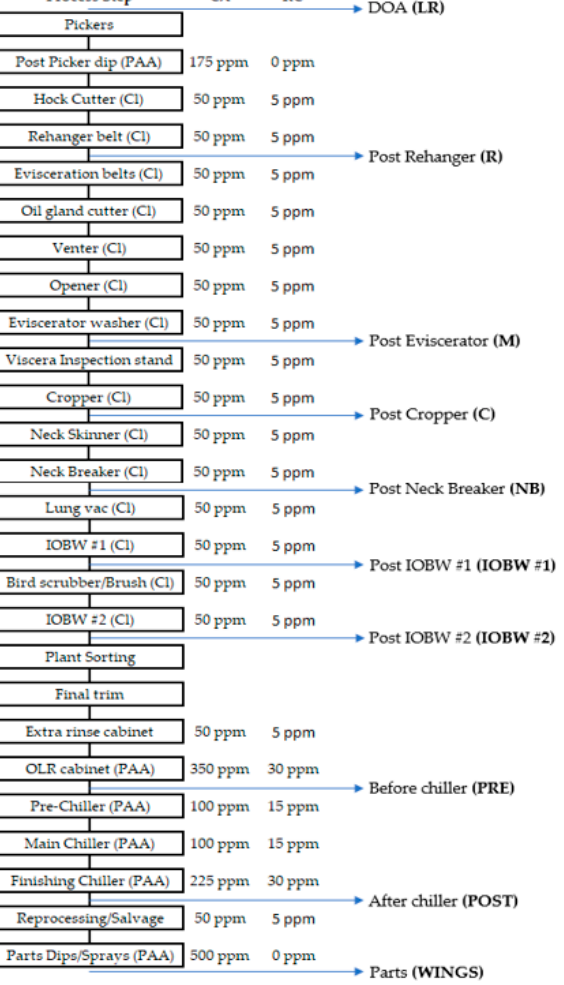
Figure 1. General flow chart of the process, identifying the CX and the RC processing schemes along with the sampling